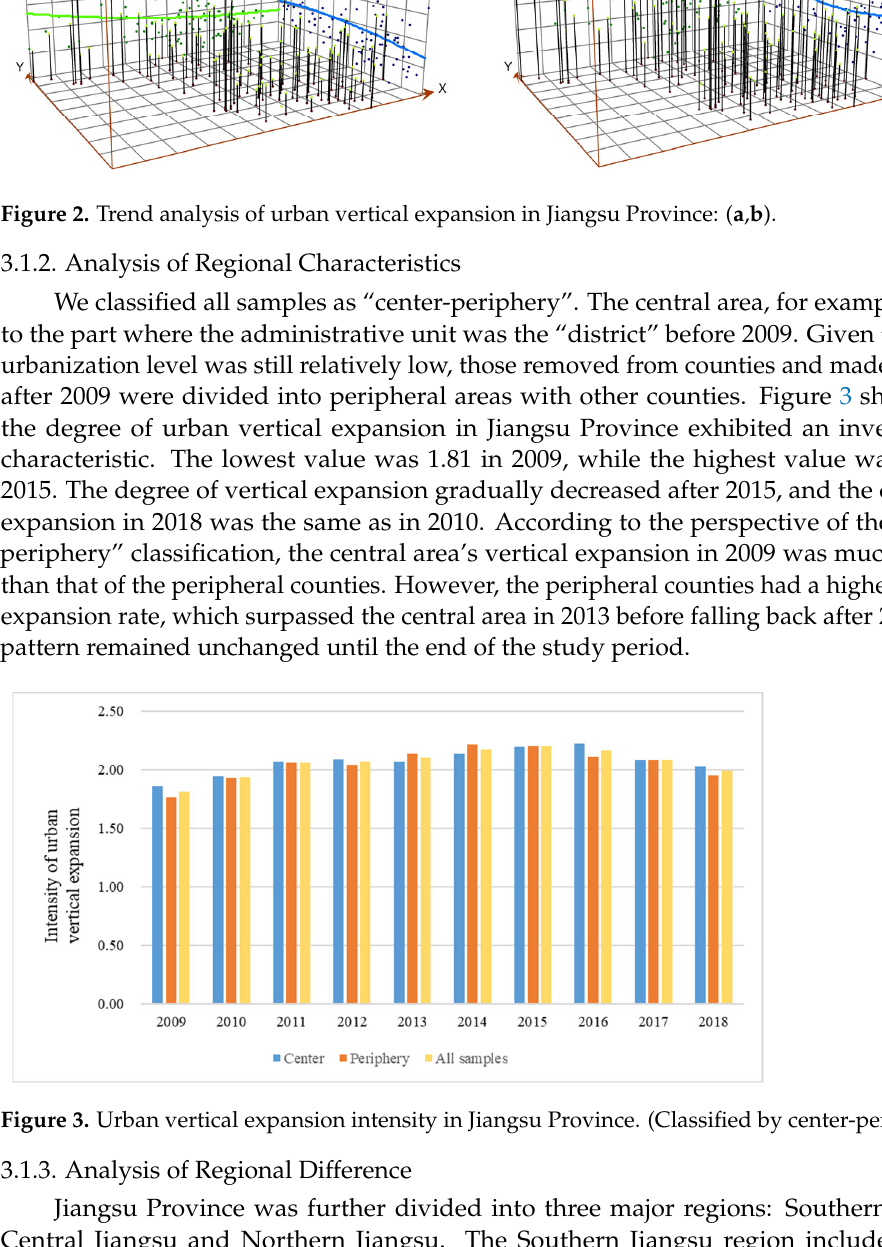
Figure 2. Trend analysis of urban vertical expansion in Jiangsu Province: ( a ) 2009, ( b ) 2018.